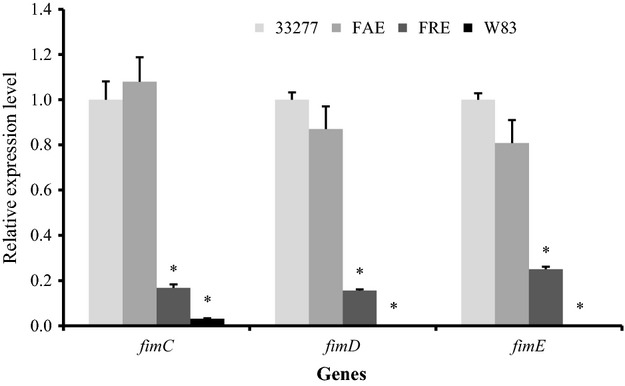
Differential expression of fimC, fimD, and fimE in Porphyromonas gingivalis strains. Total RNA was extracted from P. gingivalis 33277, fimA mutant (FAE), fimR mutant (FRE), and an afimbriated strain (W83). The expression of fimC, fimD, and fimE in P. gingivalis was measured using a quantitative reverse transcript polymerase chain reaction (qRT-PCR). Each bar represents the relative expression of the gene shown compared to that in 33277 (unit of 1.0) after normalization with the expression level of glk. An asterisk indicates a statistically significant difference in expression level of the genes between P. gingivalis FAE, FRE, or W83, and 33277 (t-test; P < 0.05).